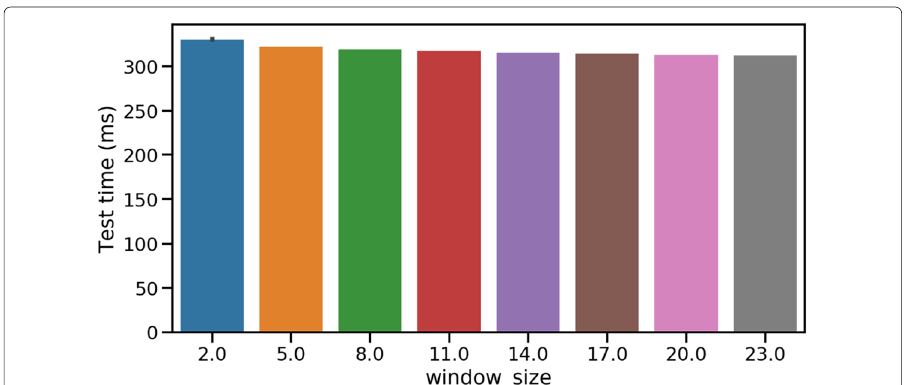
Fig. 15 Testing time for each window size. This time corresponds to the time taken to attribute a label to a tested